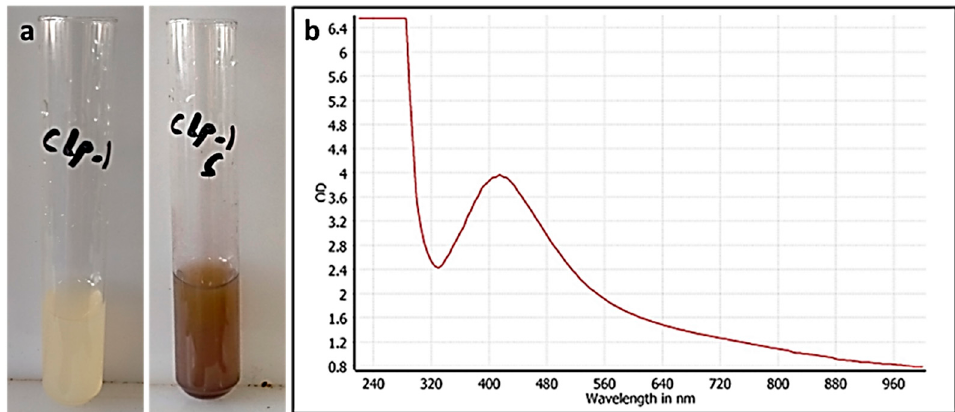
Figure 2. ( a ) Color change due to AgNPs, ( b ) UV–vis spectrum after synthesis of AgNPs.